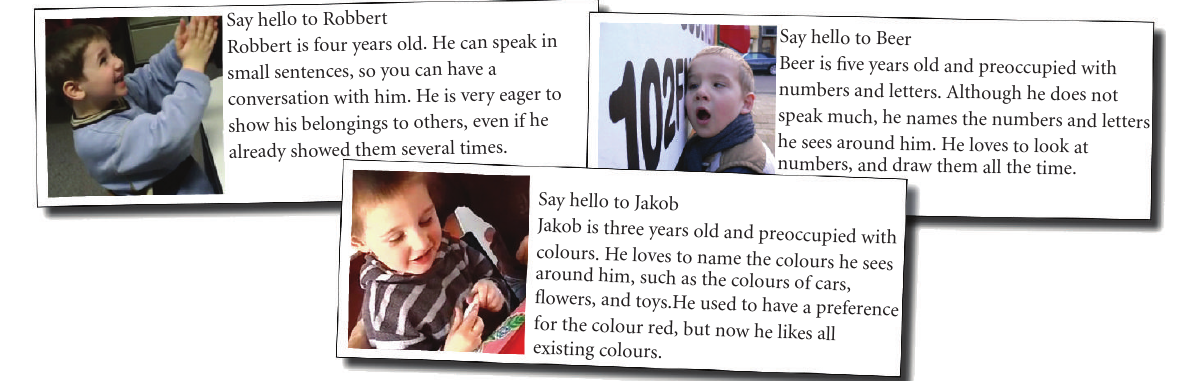
Figure 2: A short introduction to the three children in the LINKX project.